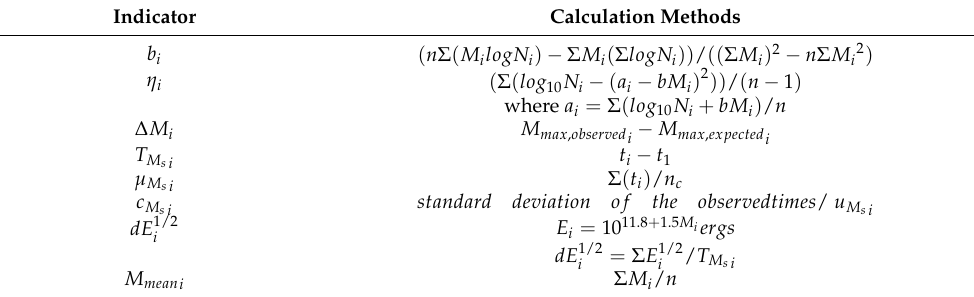
Table 1. Calculation methods of each seismic